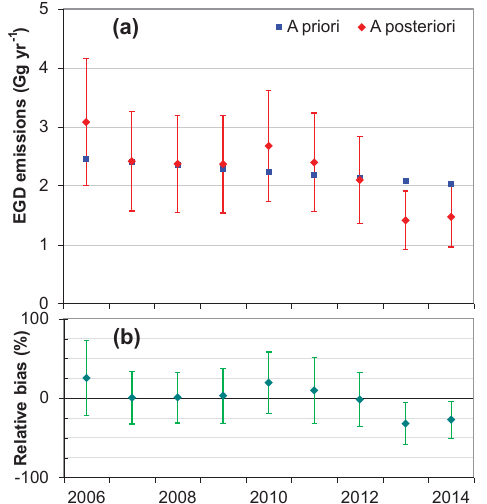
Figure 3. (a) Comparison between the a priori (blue squares) and a posteriori (red diamonds) CCl 4 emission fluxes from the Euro- pean geographical domain during 2006–2014. (b) Percentage rel- ative bias between the a priori and a posteriori time series (green diamonds).